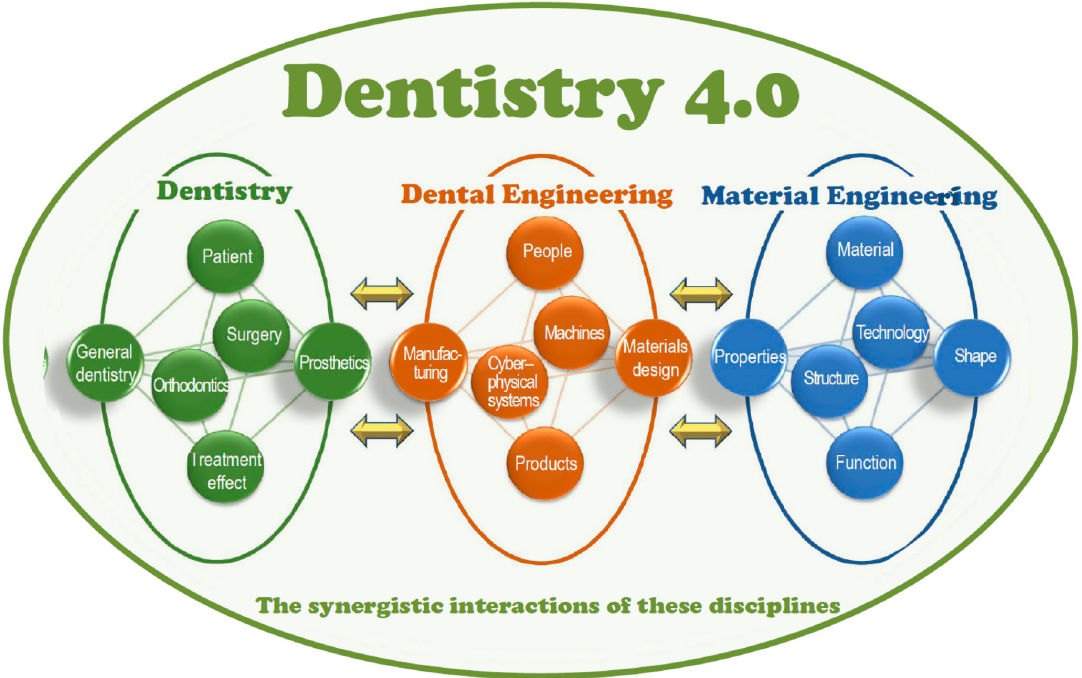
Figure 22. General diagram of the synergistic relations between dentistry, dental engineering, and materials engineering in the Dentistry 4.0 model.